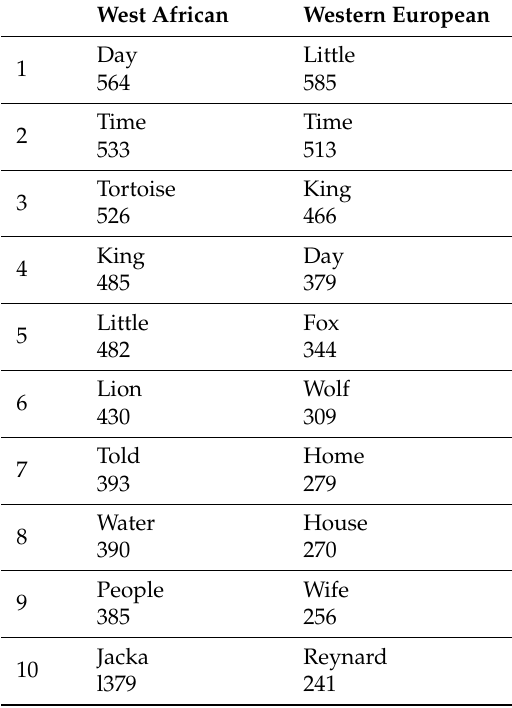
Table 3. Top 10 most frequently occurring words per corpus (type B).